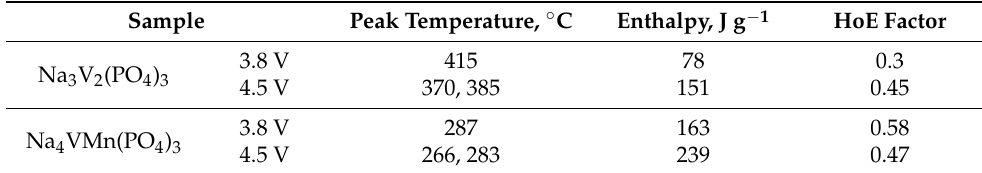
Figure 4. DSC curves for the charged electrodes containing Na 3 V 2 (PO 4 ) 3 and Na 4 VMn(PO 4 ) 3 cathode materials at different potential cut-offs (3.8 V on the bottom and 4.5 Von the top ). Table 1. Differential Scanning Calorimetry